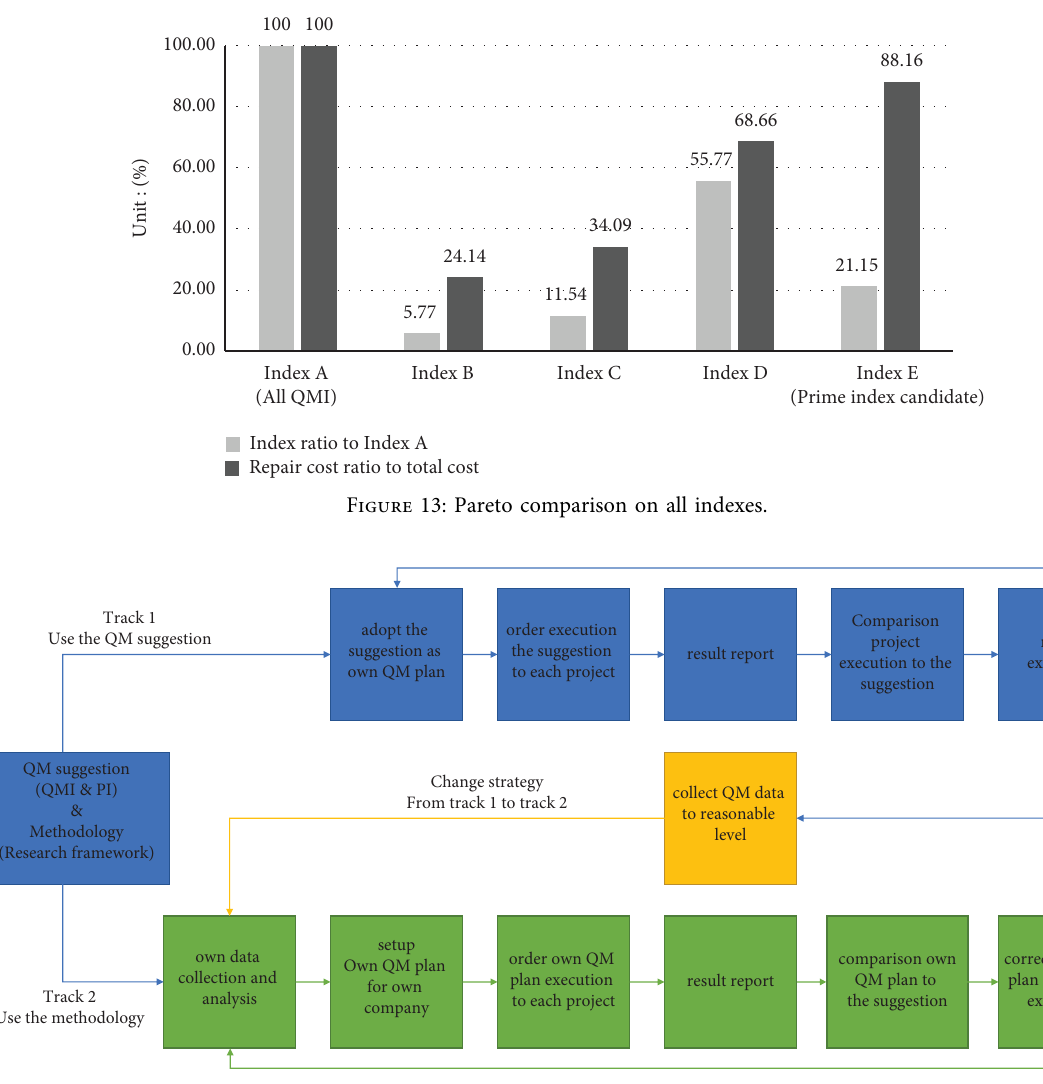
Figure 14: Quality management plan.